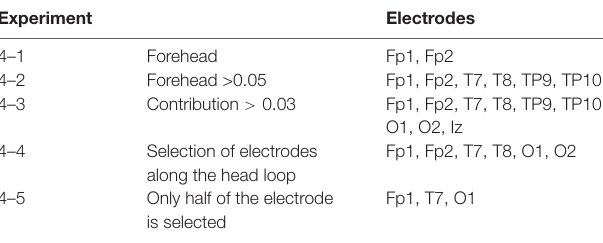
TABLE 6 | The contribution of differential entropy characteristics of each electrode to emotion classification.